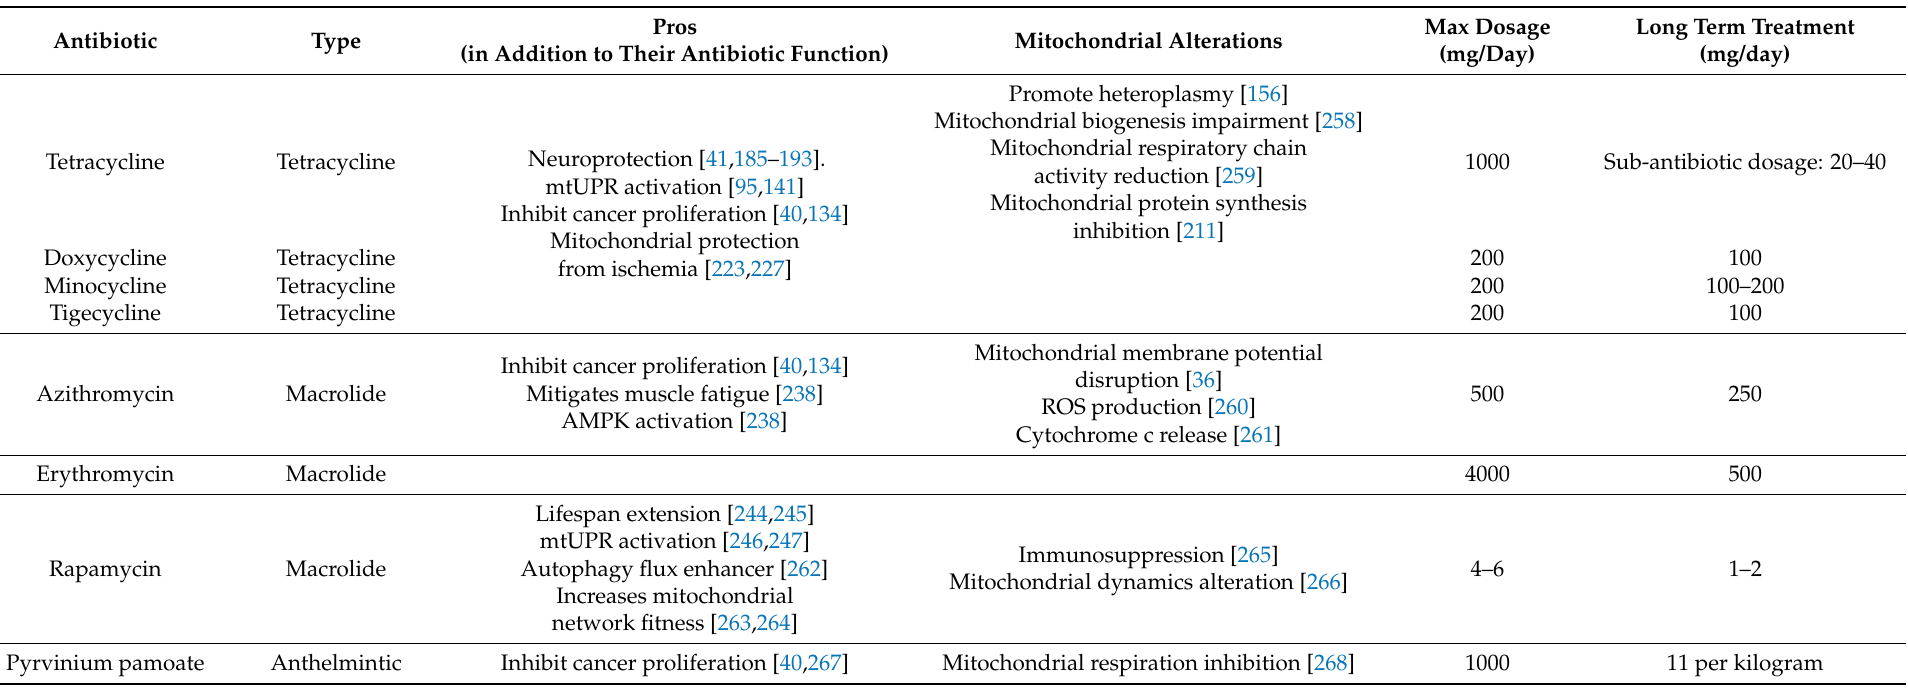
Table 1. Most studied antibiotics considering their mitochondrial benefits and adverse effects. Dosages were retrieved from Medscape